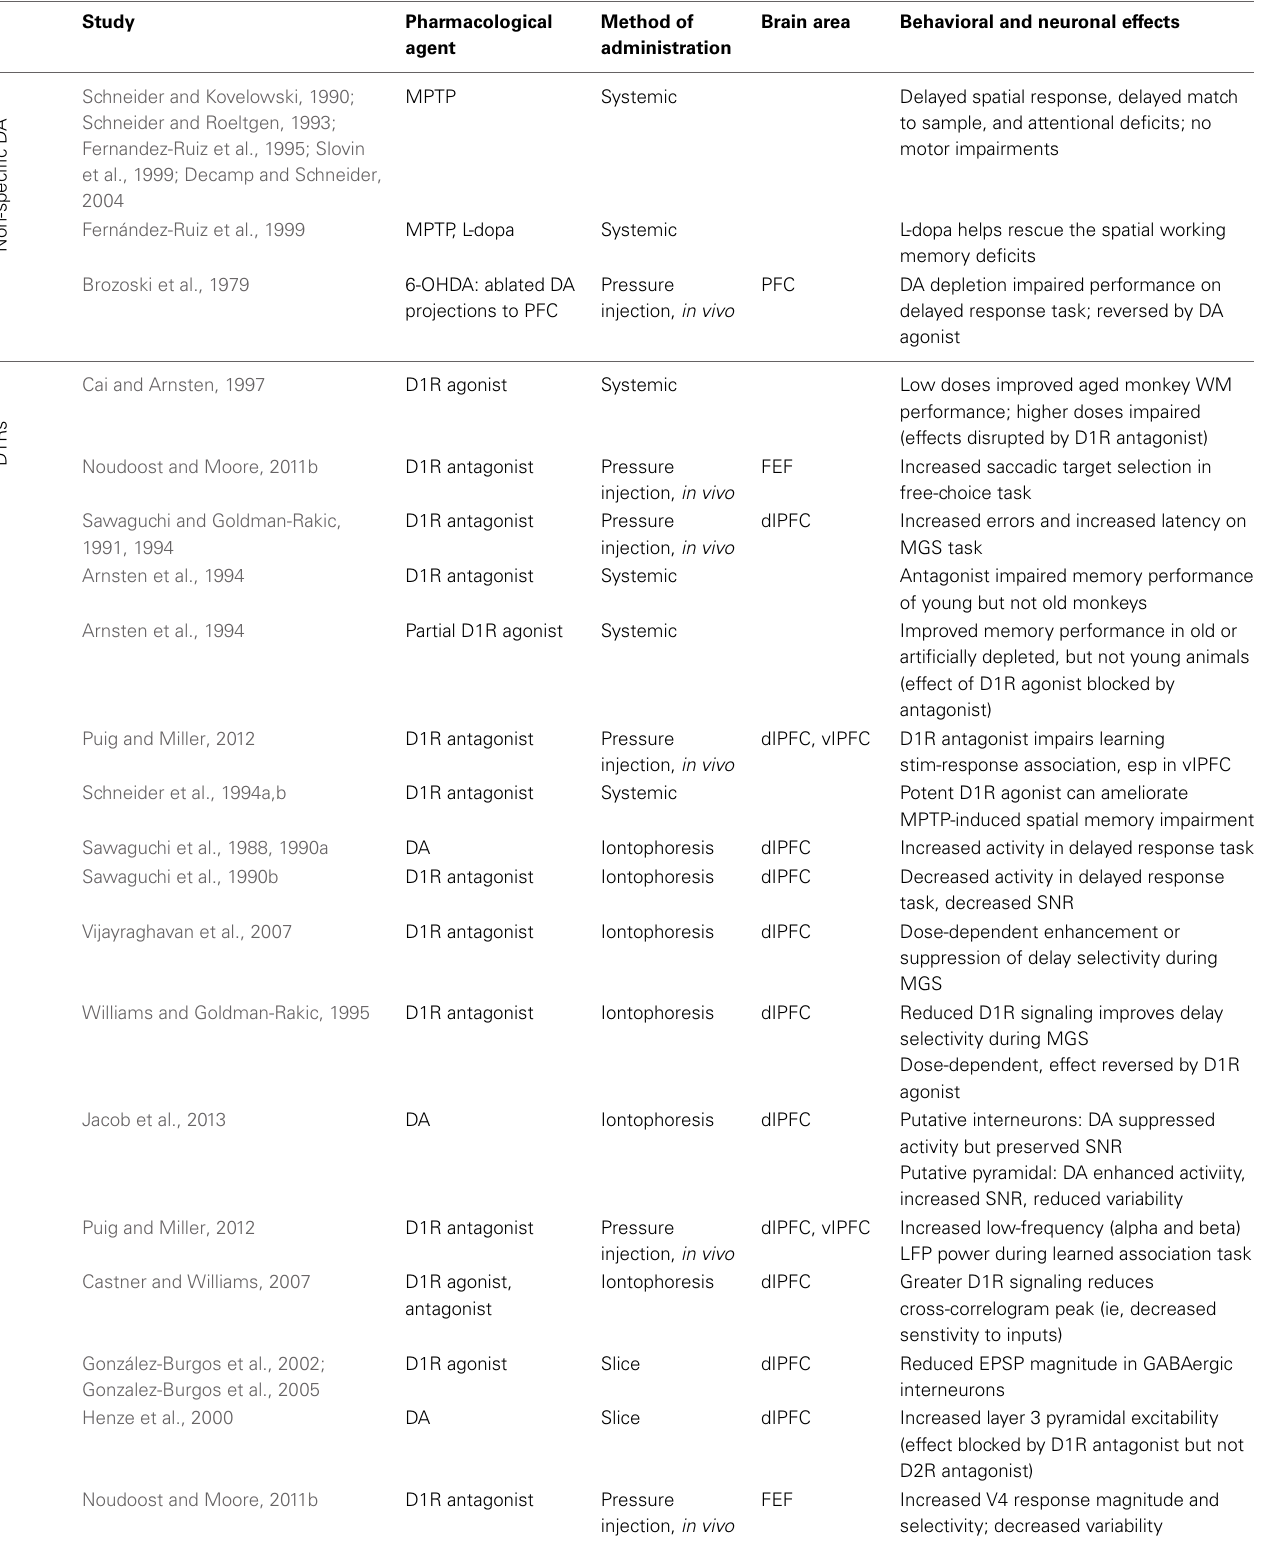
Table 1 | Studies examining the contribution of prefrontal catecholamines to the behavioral and neural correlates of working memory in non-human